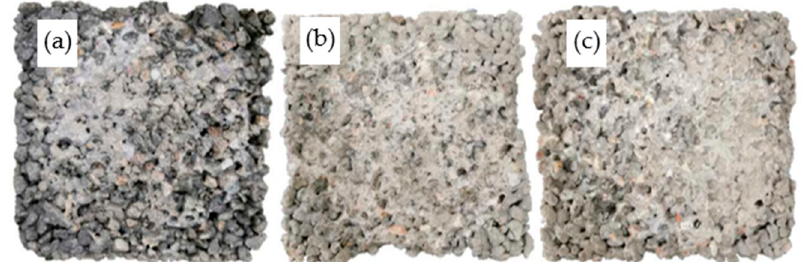
Figure 9. Surface changes of 4% SF PCPC after abrasion test. ( a ) Without wet-dry cycles, ( b ) 12 wet-dry cycles in water, and ( c ) 12 wet-dry cycles in acid rain.